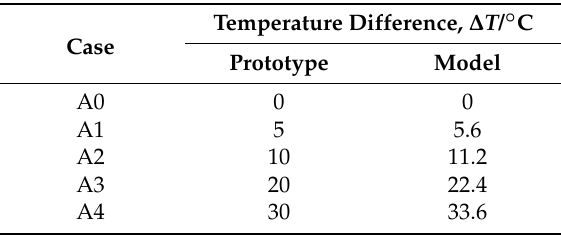
Table 3. Scheme of the non-isothermal